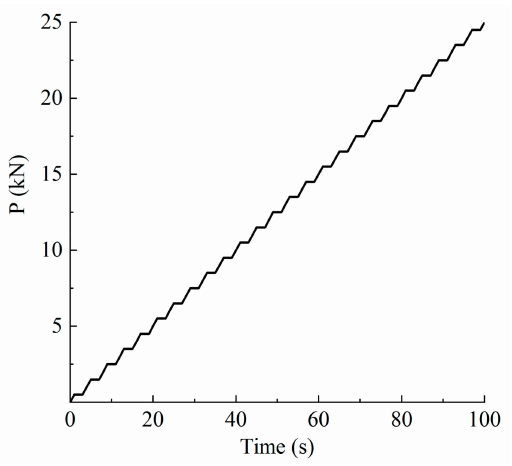
Figure 4. Pressure-time amplitude curve.